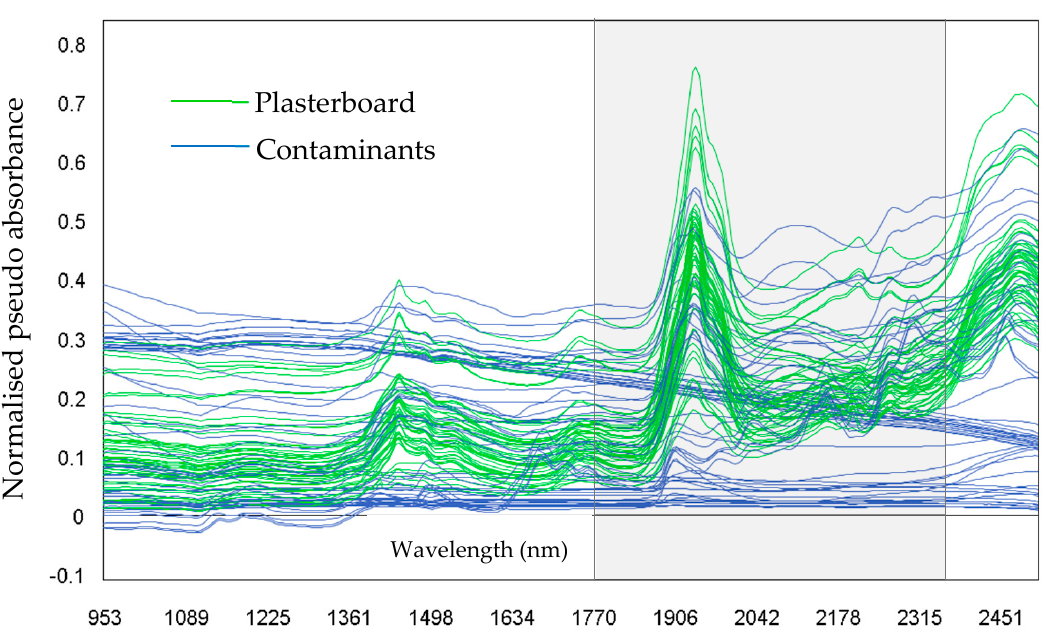
Figure 4. Spectra of samples used during model training.